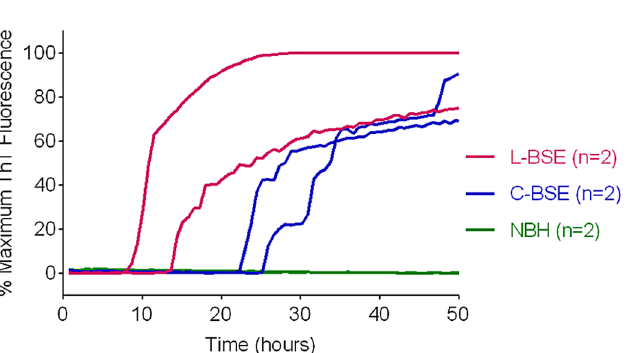
Fig 7. Detection of Classical (C-BSE) and atypical (L-type BSE) with BV rPrP Sen substrate. RT-QuIC reactions were seeded with 10 -4 brain tissue dilutions of brain stem (C-BSE, blue) or frontal cortex (L type- BSE, magenta) from Italian cattle. Negative control reactions (NBH, green) were seeded with 10 -4 dilutions of frontal cortex or brain stem from uninfected cattle. BV rPrP Sen was used as a substrate with 300mM NaCl and 0.001% SDS. RT-QuIC analysis was performed at least twice for each sample with similar results. Results are plotted as the averages from four replicate wells.